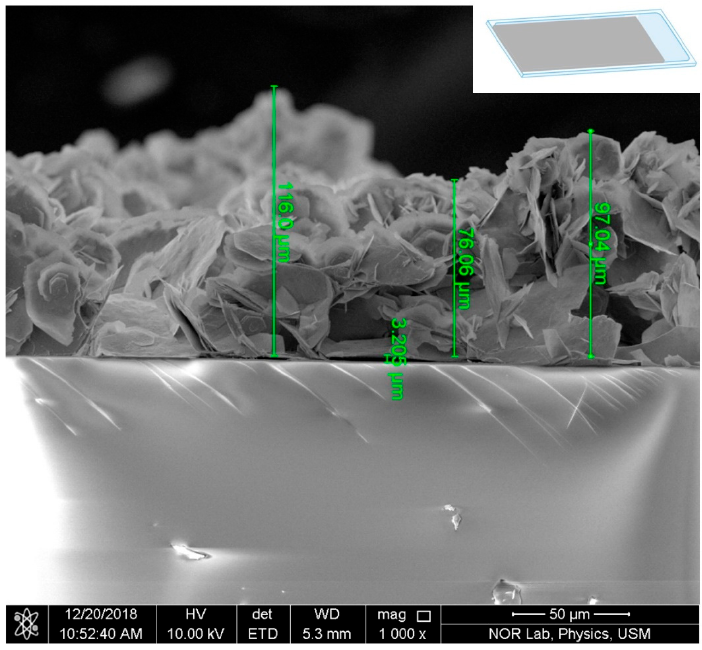
Figure 3. SEM micrograph displaying the cross section of the AZO thick film.